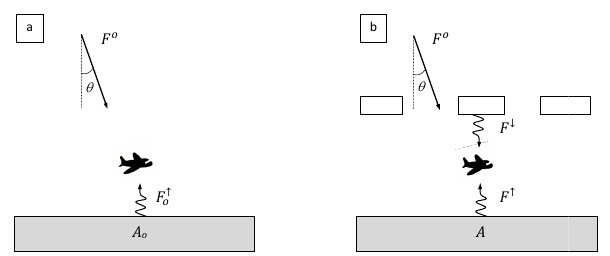
Fig. A1. (a) Cloud free situation showing the aircraft illuminated by the direct solar beam F o incident with solar zenith angle θ , and ↑ the up-welling radiation F o reflected by the Lambertian surface of albedo A o . Rayleigh scattering is neglected in this idealized exam- ple. (b) Addition of clouds above the aircraft results in a down- welling diffuse actinic flux F ↓ , while clouds below the aircraft in- crease the reflectivity below the aircraft with an effective albedo A to give an up-welling actinic flux F ↑